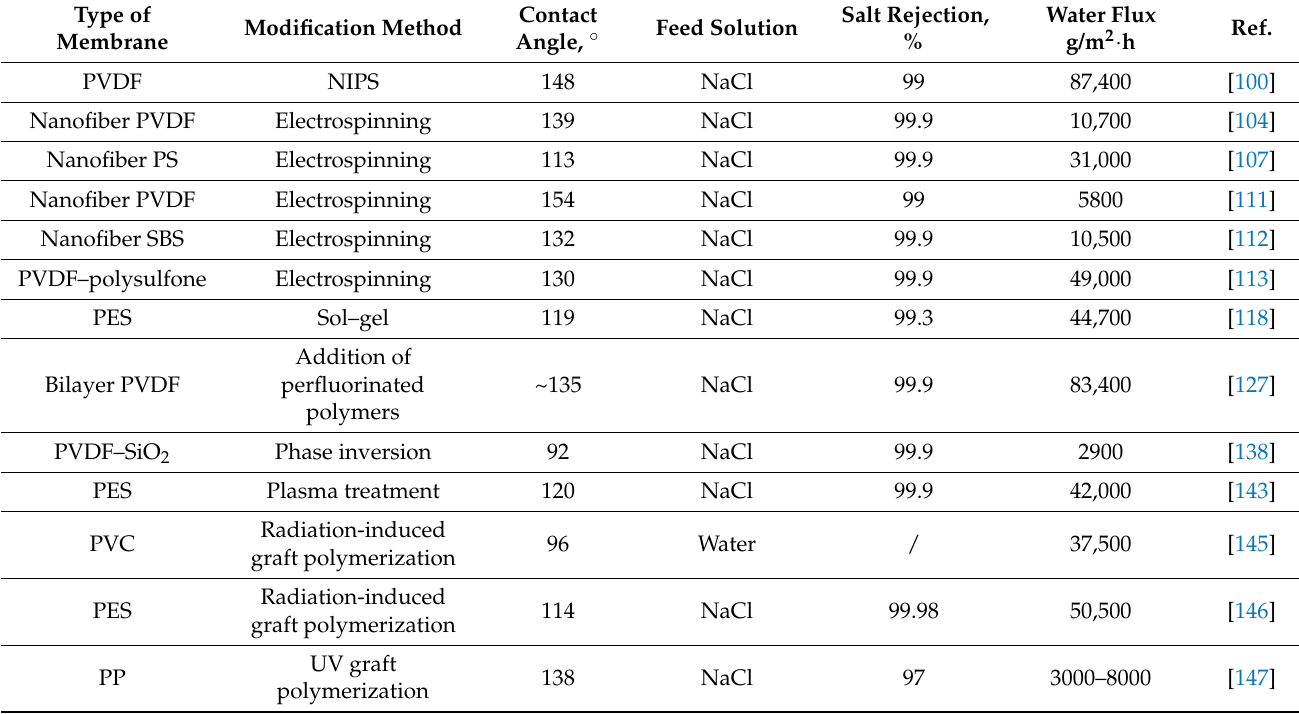
Table 1. Properties of some membranes used in MD modified by different